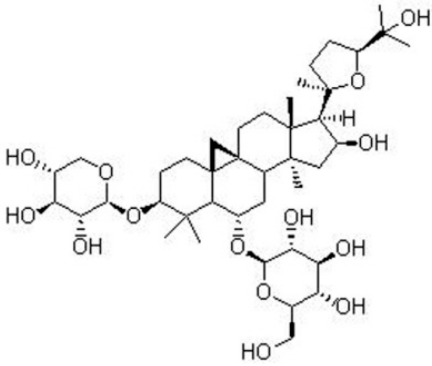
Figure 2. Chemical structures of Astragaloside IV.